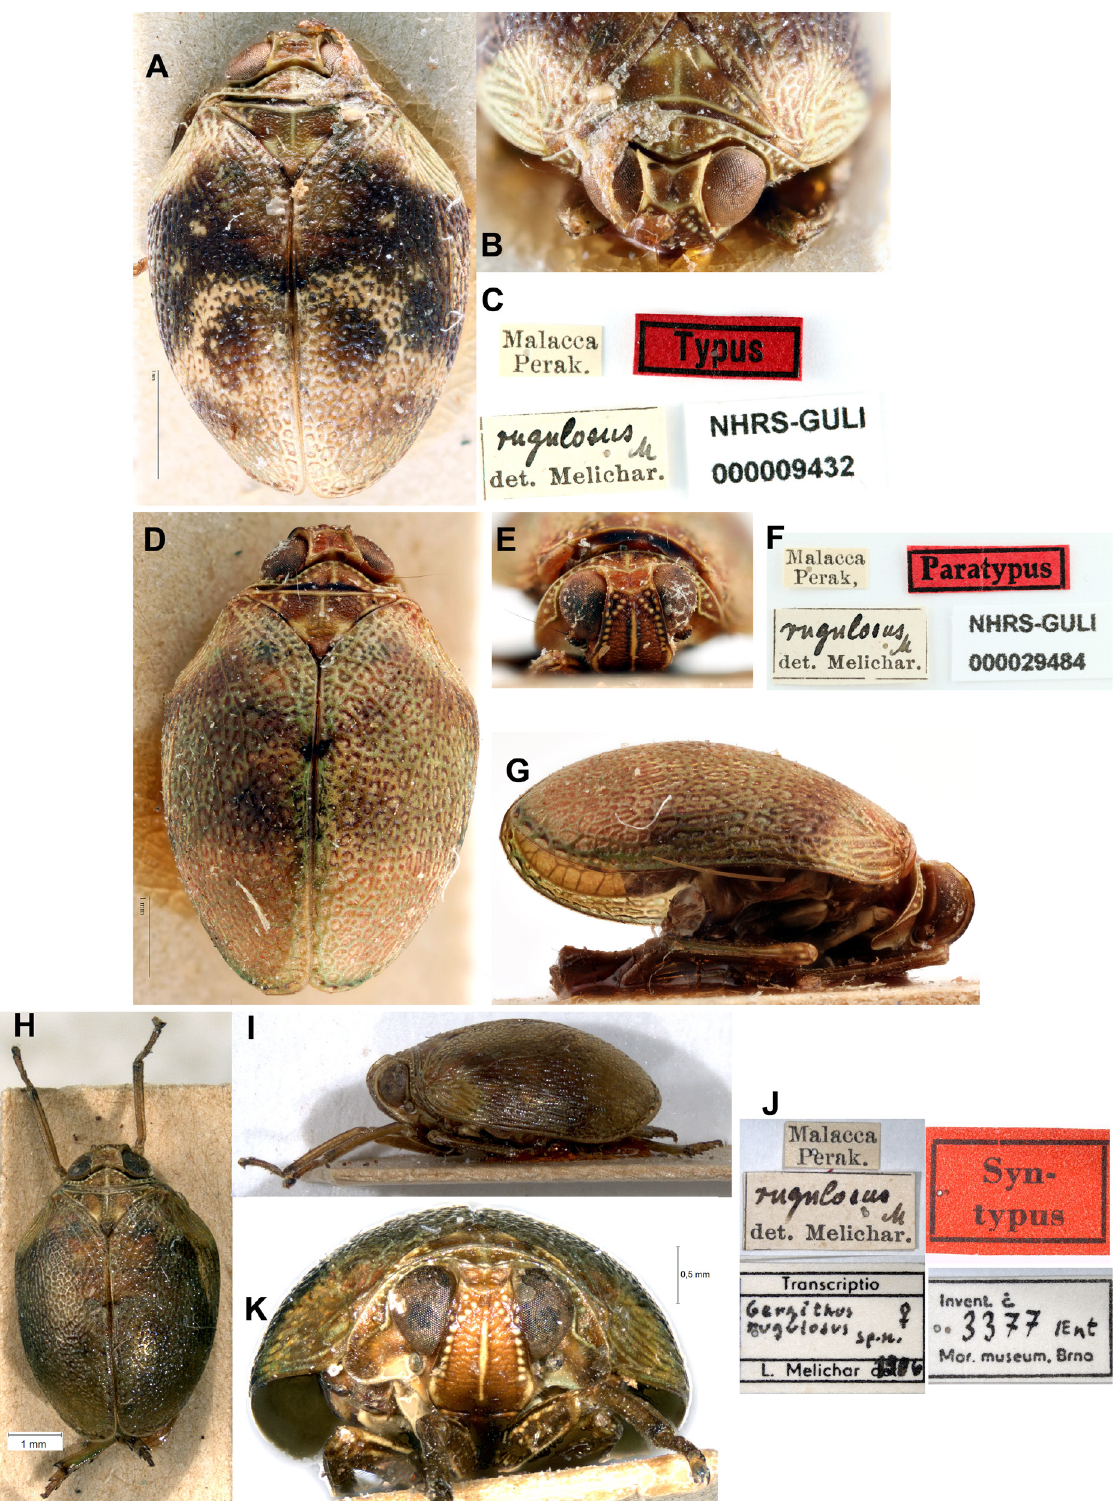
Fig. 8. Gergithoides rugulosus Melichar, 1906, syntypes. A–C . Male syntype in NHRS (photographs © G. Lindberg – NHRS). D–G . Female syntype in NHRS (photographs © G. Lindberg – NHRS). H–K . Female syntype in MMBC (photographs © I. Malenovsky – MMBC). A, D, H. Dorsal views. B. Head and thorax, dorsal view. C, F, J. Labels. E, K. Frontal views. G, I. Lateral